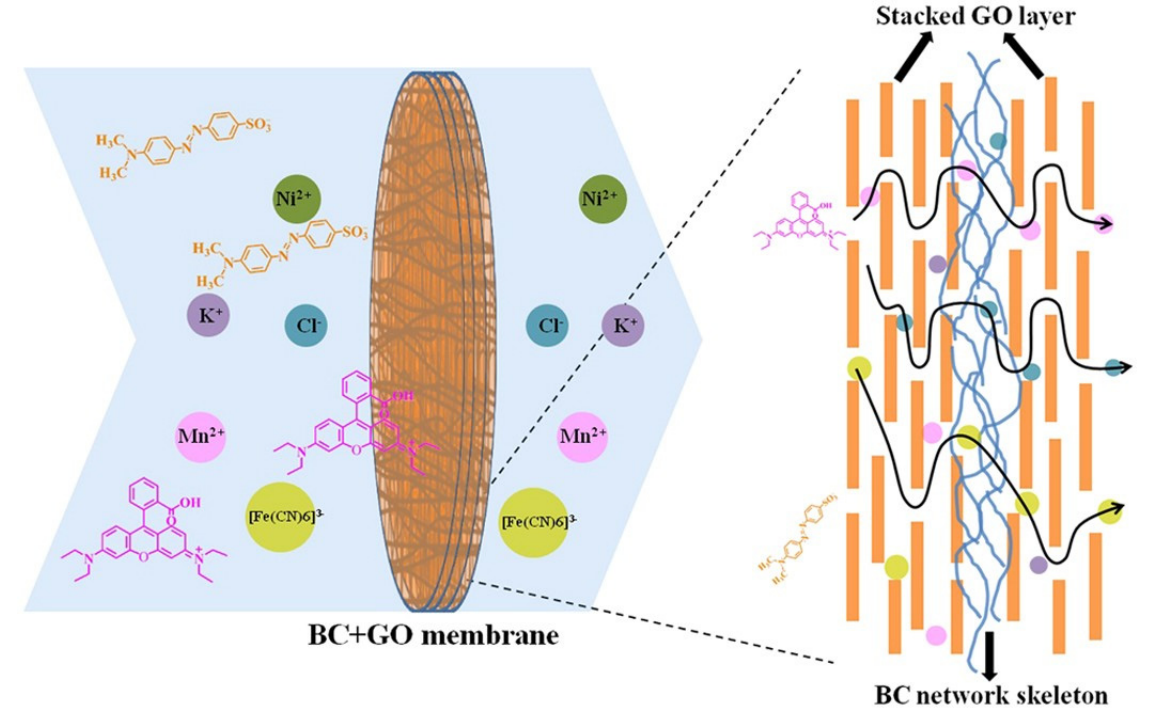
Figure 12. Mechanisms of free–standing bacterial cellulose and graphene oxide membrane for se- lective ion permeation. Adapted with permission from Fang et al. [70] . Copyright (2016) Scientific Reports.